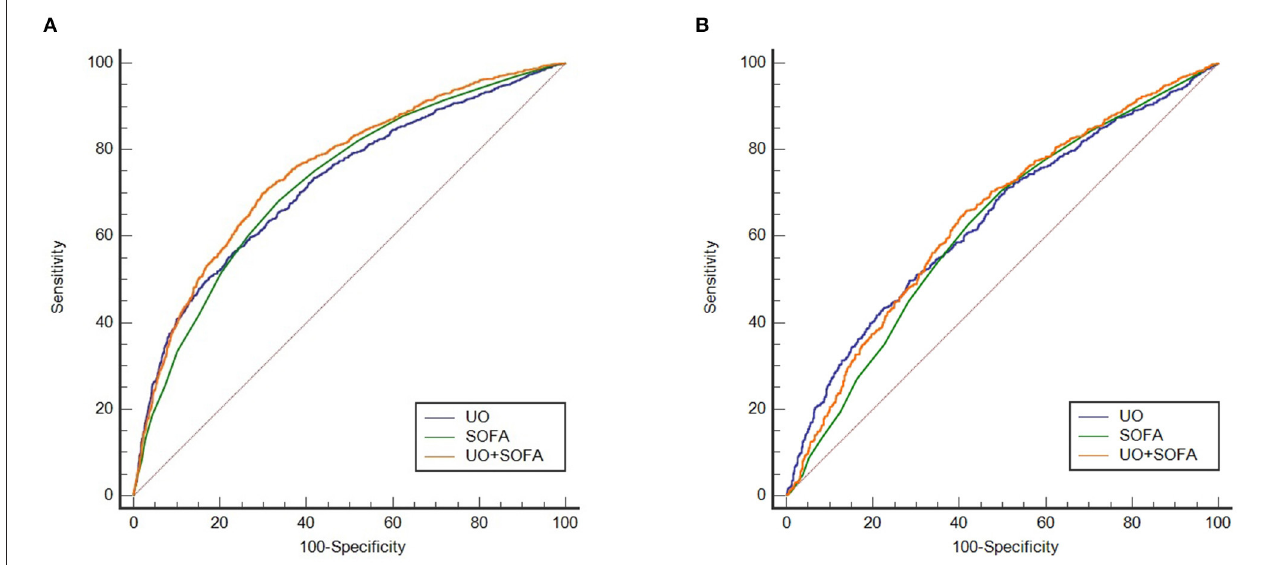
FIGURE 2 | (A) ROC curves of UO, SOFA, UO + SOFA (before propensity score matching); (B) ROC curves of UO, SOFA, UO + SOFA (after propensity score matching). UO, Urine Output (mg/kg/h); SOFA, Sequential Organ Failure Assessment.